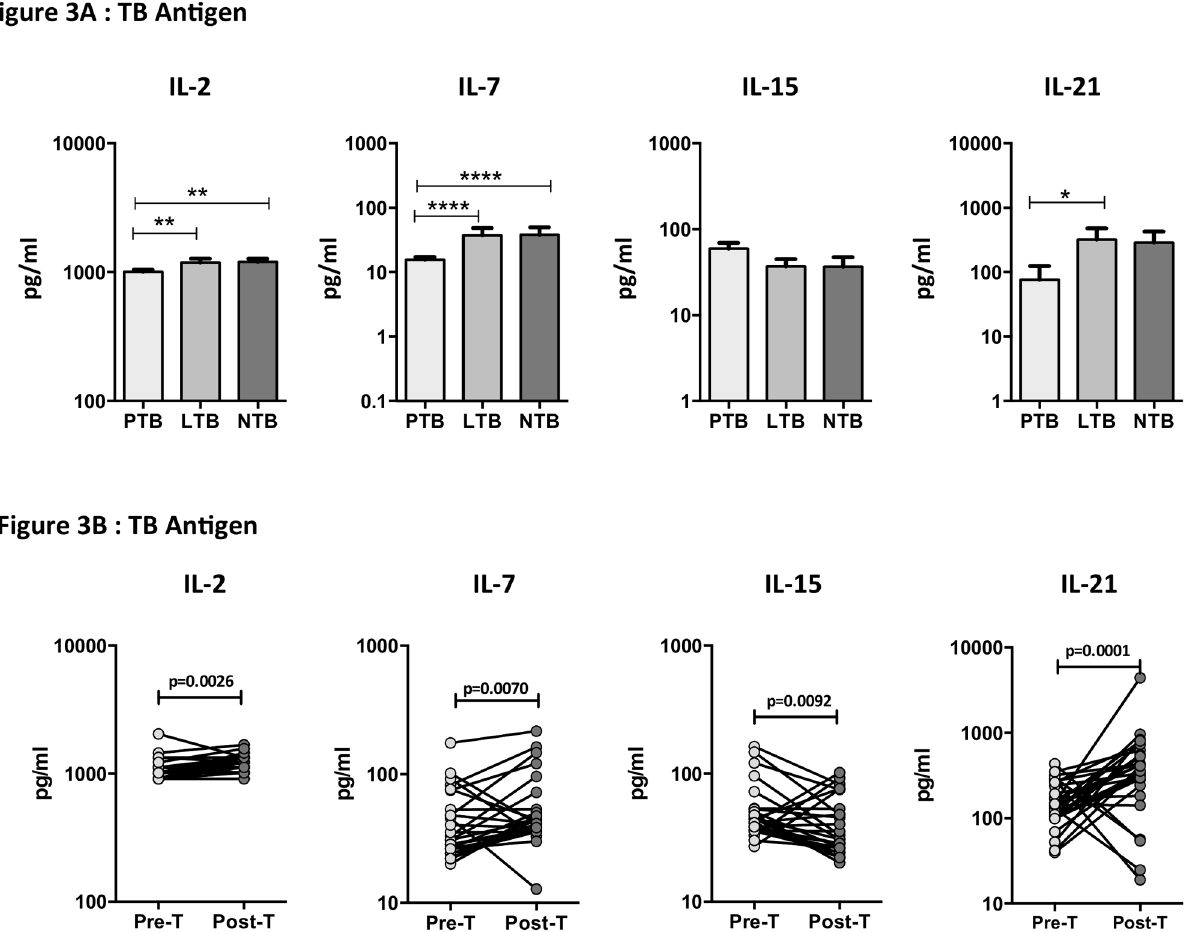
Fig 3. Diminished tuberculosis (TB) antigen–stimulated levels of common γ -chain cytokines in PTB individuals and restoration following anti-TB treatment. (A) TB antigenstimulatedlevels of common γ -chain cytokines IL-2, IL-7, IL-15 and IL-2 were measuredin PTB (n = 30), LTB (n = 30) and NTB (n = 30) individuals. The data are representedas bar graphs showinggeometric means and 95% confidenceintervals. P values were calculatedusing the Kruskal-Wallis test with Dunn’spost hoc comparison. (B) TB antigenstimulated levels of common γ -chain cytokines IL-2, IL-7, IL-15 and IL-2 were measuredin PTB individualsbefore (pre-T) and after (post-T) standard anti-TB chemotherapy. The data are representedas line graphs with each line representinga singleindividual.P values were calculated using the Wilcoxon signedrank